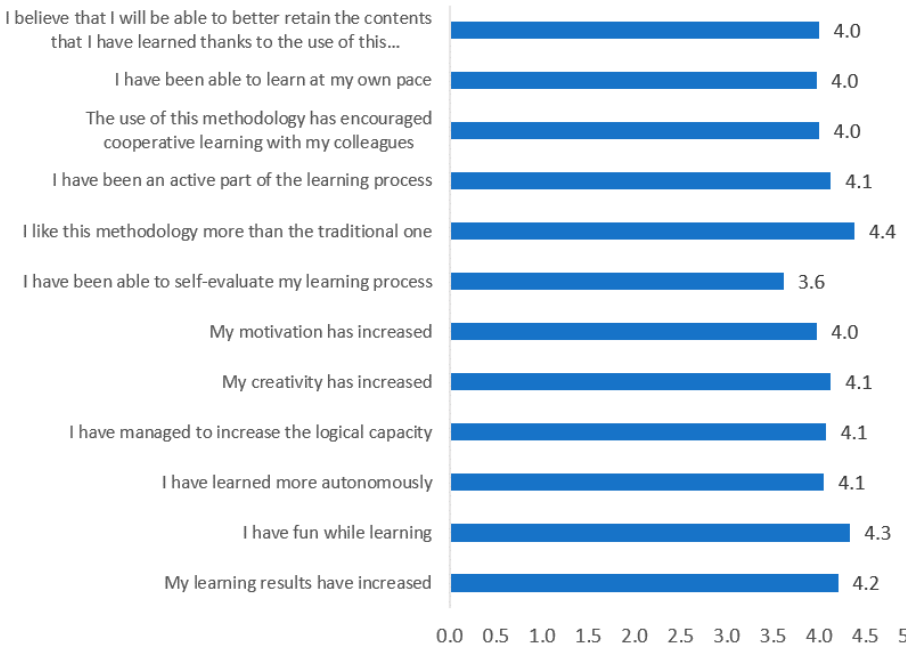
Figure 8. Average results of the assessment of Likert-type scale items of the user experience in the experimental